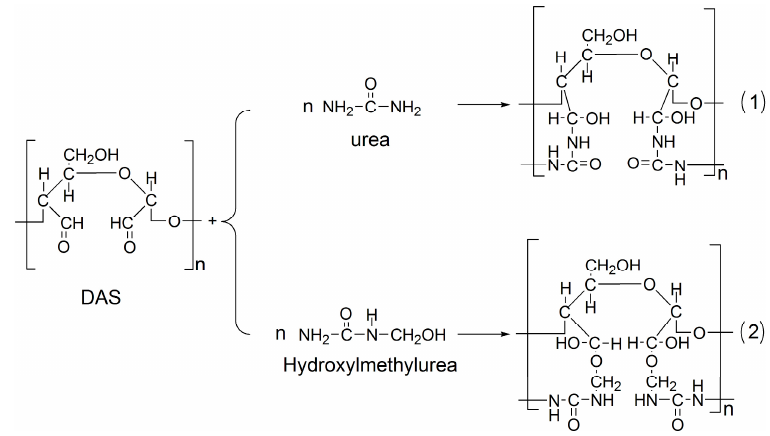
Figure 4. Polymerization of DAS and urea and hydroxymethylurea.